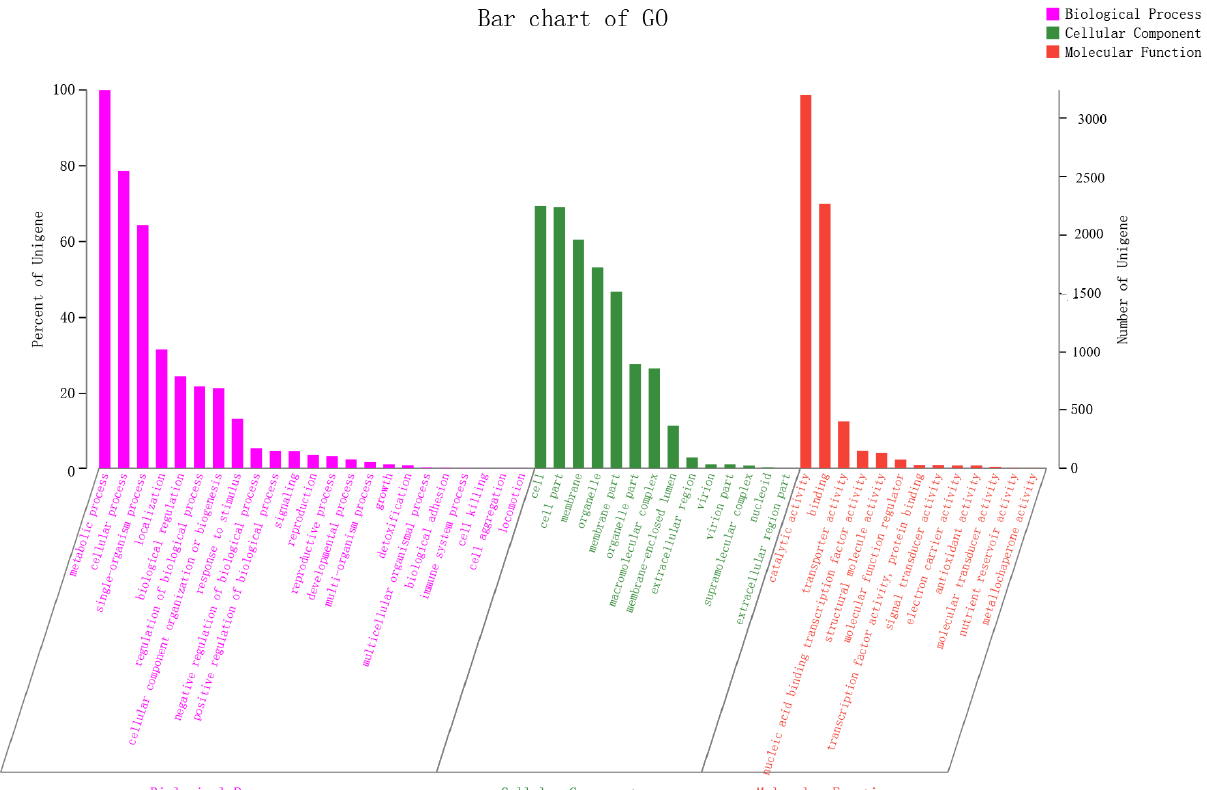
Figure 8. Transcript GO annotation classification statistics graph.